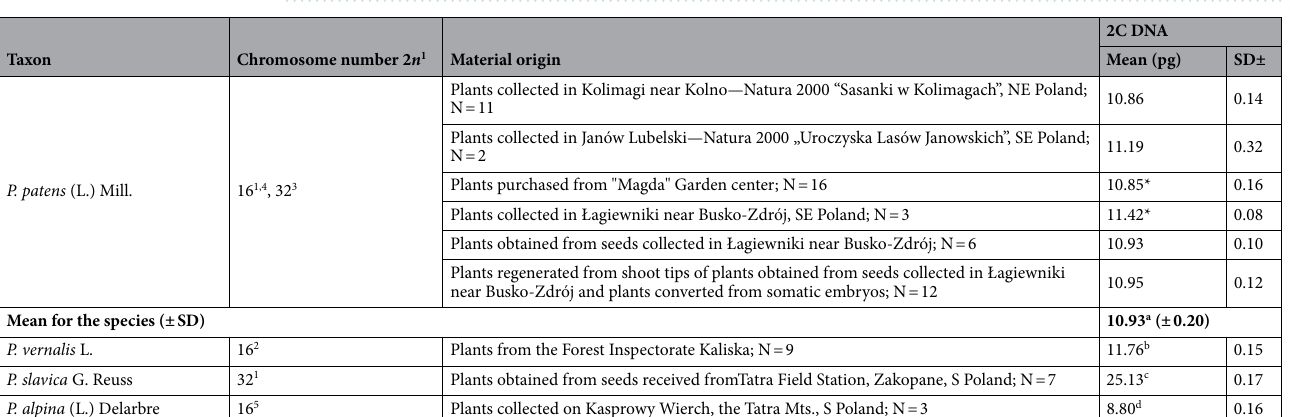
Figure 2. NeigborNet of Pulsatilla patens constructed on 51 ISSR loci using Dice distance. Branch support values are based on bootstrap analysis with 1000 replicates. Ł—plants from natural population in Łagiewniki near Busko-Zdrój, marked in blue circles; BZ—seedlings from seeds harvested in Łagiewniki near Busko-Zdrój, marked in red circles; R—regenerated plants from Łagiewniki near Busko-Zdrój seedling explants, marked in green circles.